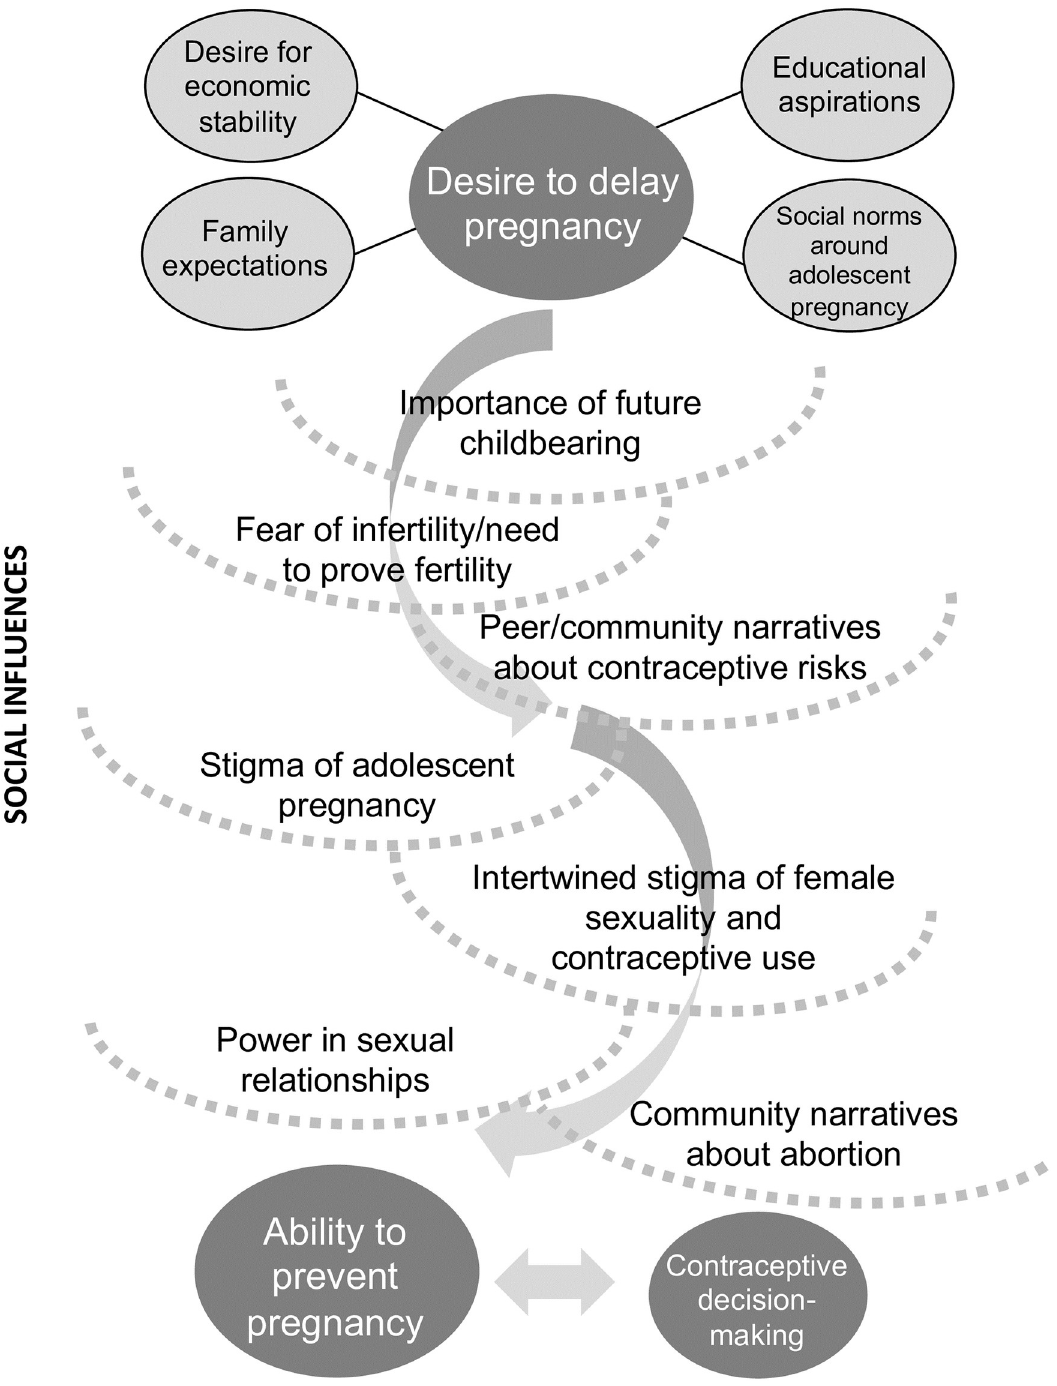
Fig 2. Conceptual model: Social influences on adolescent contraceptive decision-making.